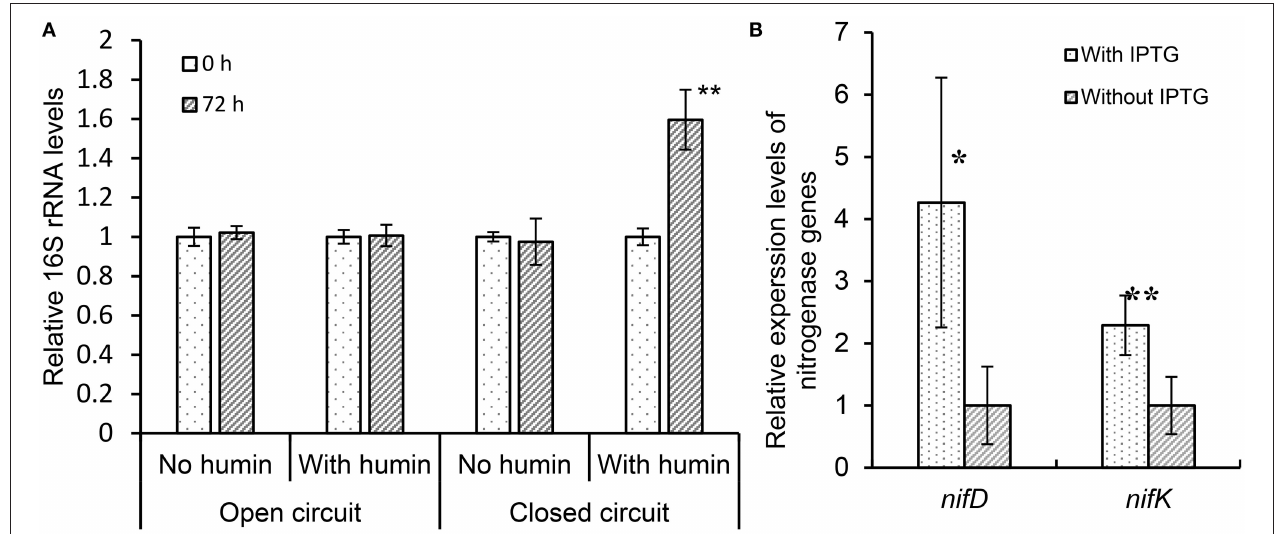
FIGURE 6 | The growth of the nifDK -overexpression mutant ( nifDK -OE) under nitrogen-deficient conditions in the presence of isopropyl β - D -1-thiogalactopyranoside (IPTG) (A) and the relative expression levels of nitrogenase genes nifD and nifK in the nifDK -OE mutant under the conditions with and without IPTG (B) . Error bars represent standard deviations of the four measurements. The symbols “*” and “**” indicate significant differences at p < 0.05, and p < 0.01, respectively.